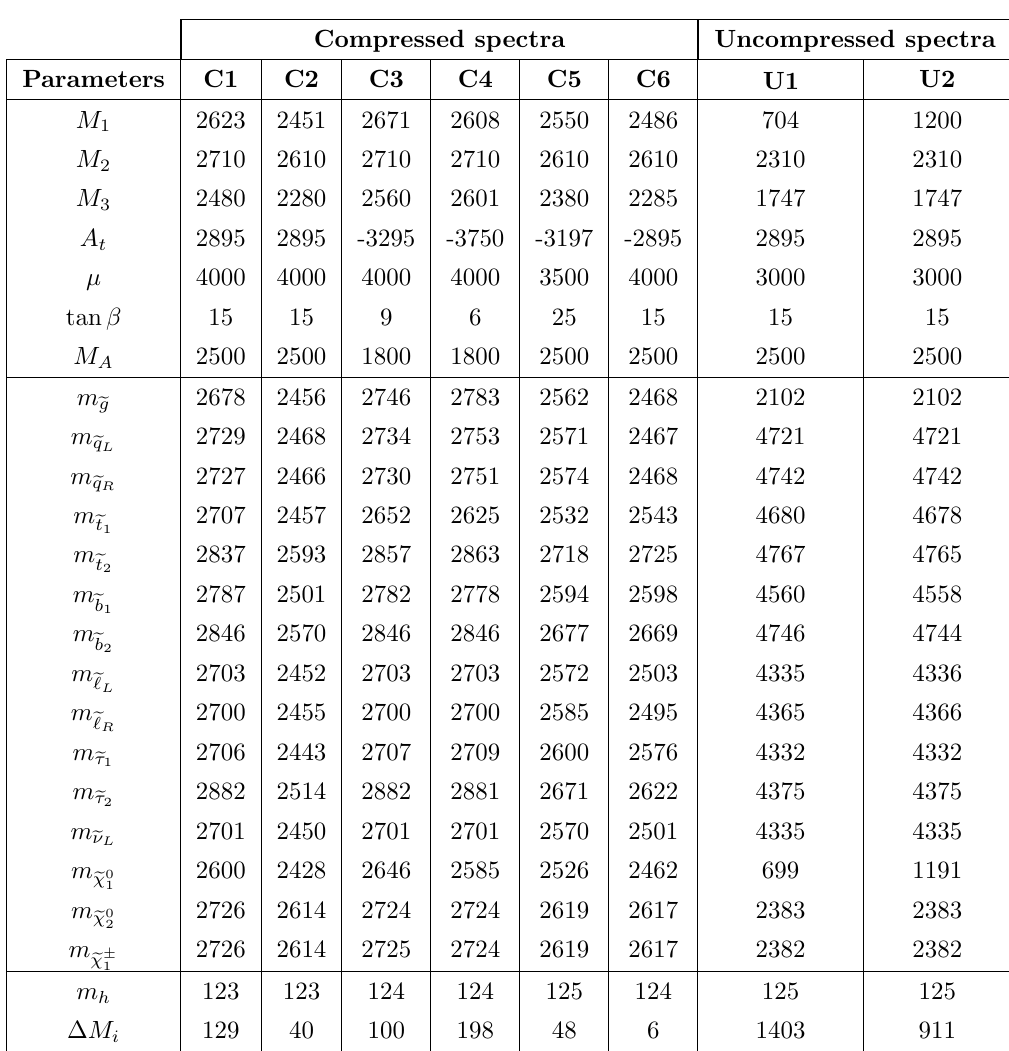
Table 1 . Low energy input parameters and the relevant sparticle masses, (in GeV), for the com- pressed ( C i , i = 1,...,6) and uncompressed ( U1 , U2 ) benchmarks. Here, (cid:1) M i = m i (cid:0) m m i represents the mass of the heaviest coloured sparticle ( the NLSP. For all benchmarks, the gravitino mass, m